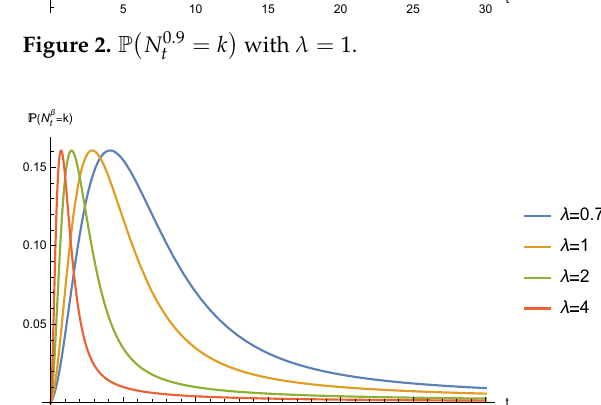
(cid:0) = 3 (cid:1) . N 0.9 t